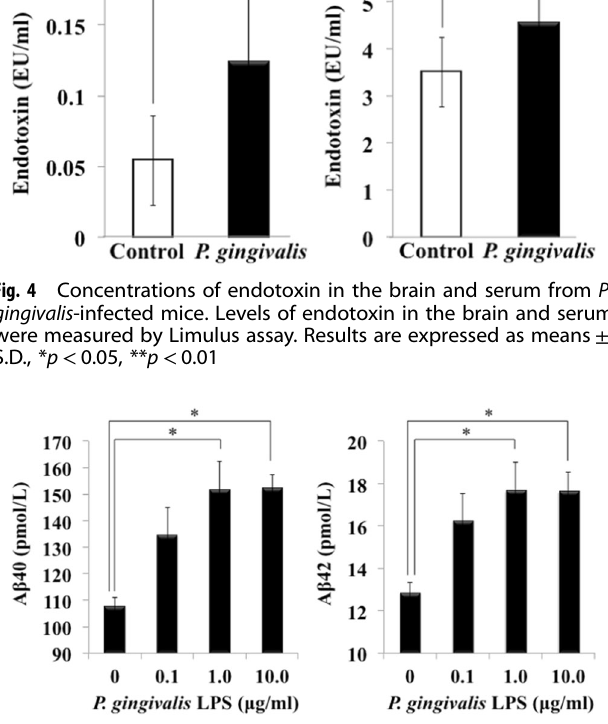
Fig. 5 P. gingivalis LPS induces A β production in mouse neural cell cultures. Neural cells isolated from mouse brain were stimulated with P. gingivalis LPS for 24 h. Amounts of A β 40 and A β 42 in the media were measured by ELISA ( n = 3, mean ± S.D., * p < 0.05)